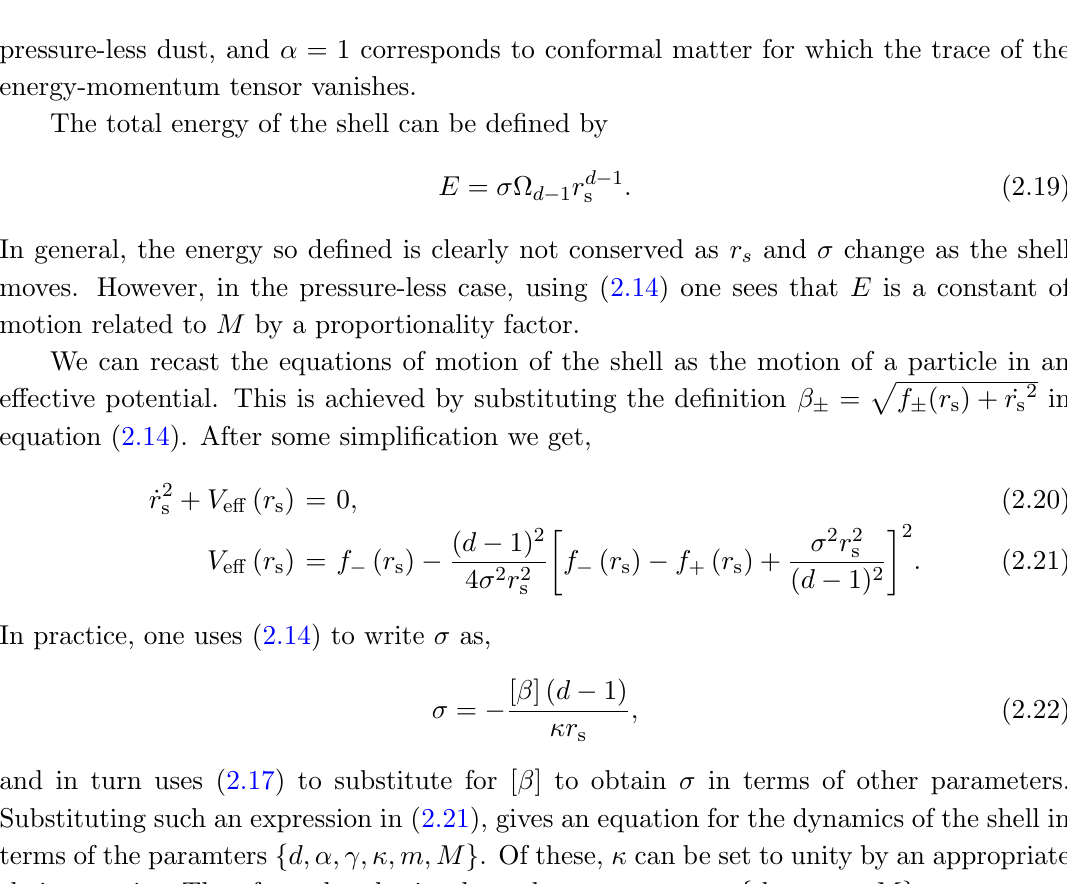
Figure 1 . The two limiting cases within which oscillatory shell motion exists. We have chosen (cid:11) = 0 : 3, d = 3, m = 0 : 1, M up =m = 0 : 38 (the top solid curve) and M low =m = 0 : 35 (the bottom dashed